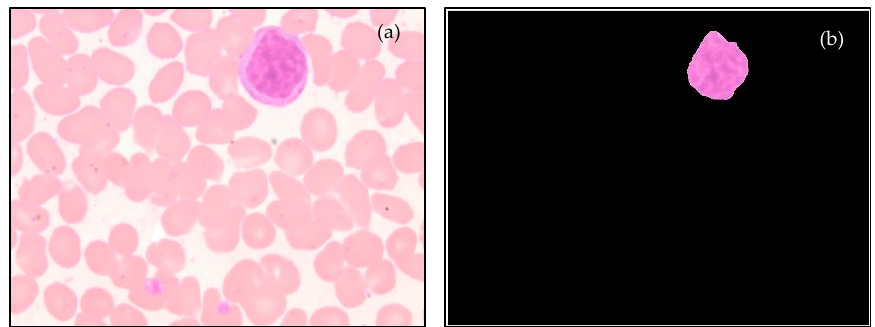
Figure 7. Sample results of segmentation process: ( a ) Dengue-infected lymphocyte, and ( b ) Seg- mented nucleus.